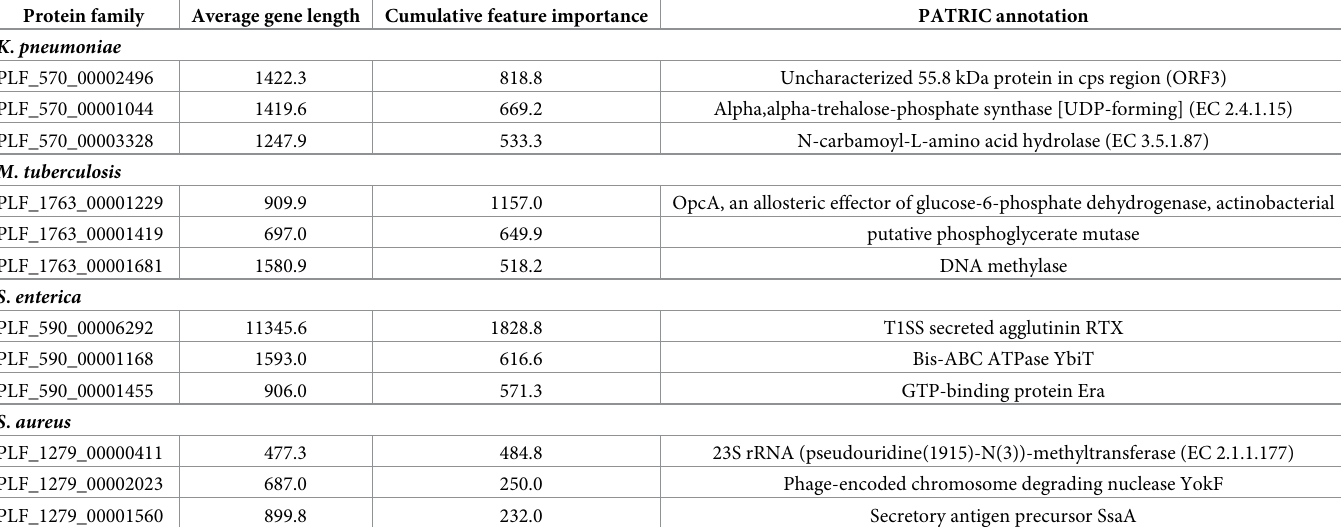
Table 3. The top three genes with the highest total feature importance from all k-mers used in each model. Results are based on ten separate models built from 100 randomly sampled non-overlapping core gene sets. Protein family Average gene length Cumulative feature